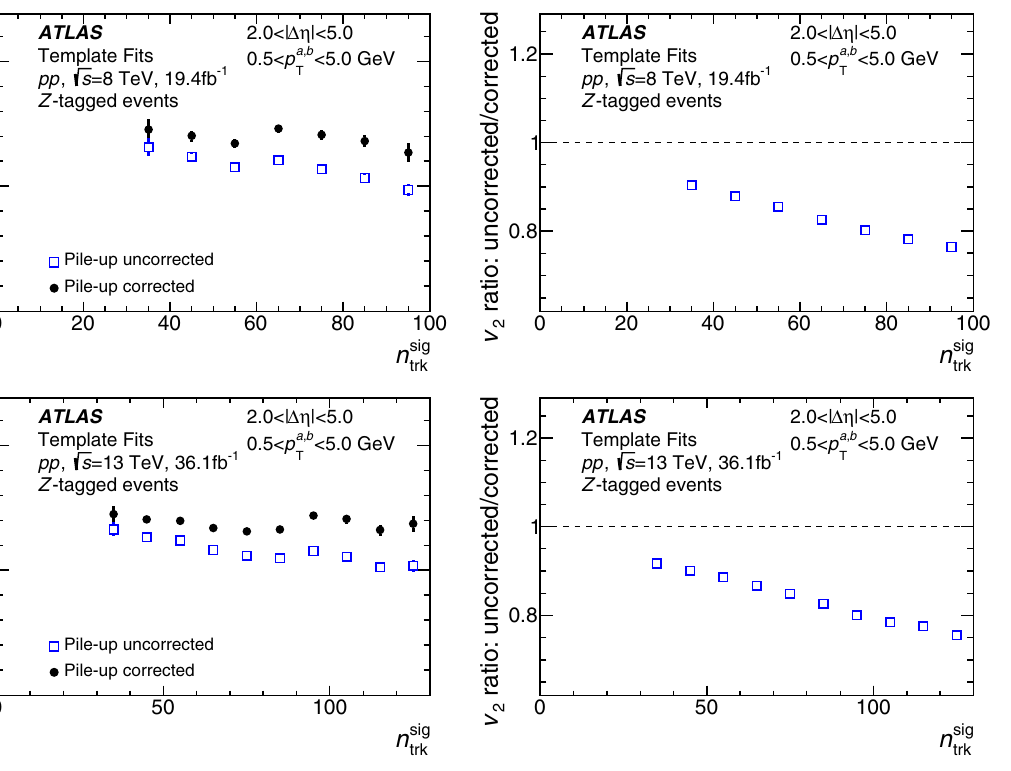
Fig. 9 Top left panel shows the v 2 values obtained from the multiplicity – so that the effect of the pile-up correction on the v n is template fits in the 8 TeV data, corrected for pile-up, plot- compared between the same set of events. The top right panel shows the ratio of the two v 2 values. Bottom row shows similar plots for the ted as a function of the n sig (black points). For comparison, trk 13 TeV data. The error bars indicate statistical uncertainties and are not the v 2 not corrected for pile-up is also plotted. The uncorrected shown in the ratio plots. Plots are for 0 . 5 < p a , b sig v – the pile-up corrected 2 is also plotted as a function of n trk